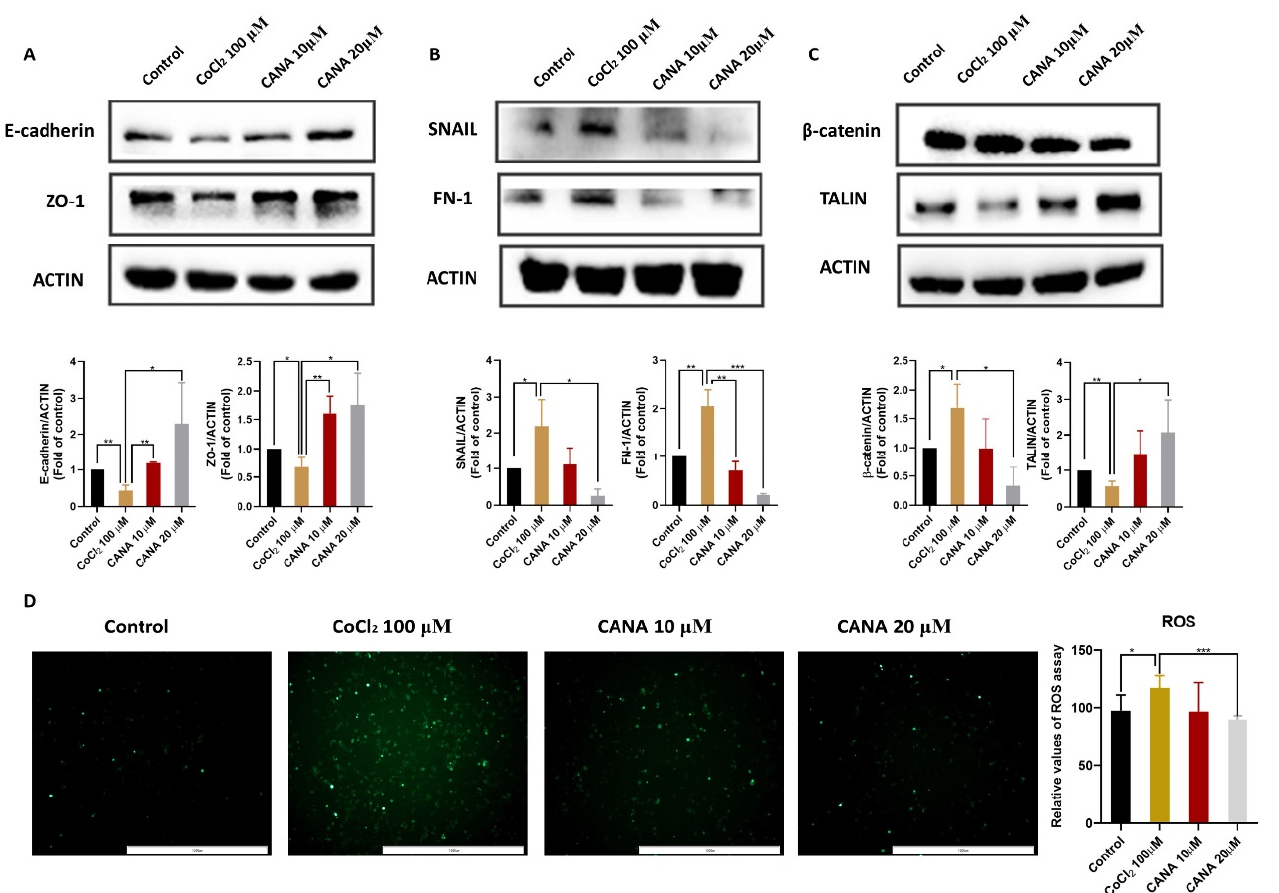
Figure 2. CANA inhibited hypoxia-induced epithelia-to-mesenchymal transition. ( A ) Effect of CANA on the protein expression of the epithelial marker in hypoxia-induced HepG2 cells after 24 h. ( B ) Effect of CANA on the protein expression of the mescenchymal marker in hypoxia-induced HepG2 cells after 24 h. ( C ) Effect of CANA on the protein expression of β -catenin and talin in hypoxia-induced HepG2 cells after 24 h. ( D ) Effects of CANA on reactive oxygen species (ROS) in hypoxia-induced HepG2 cells after 24 h (100 × ). Data were shown as means ± S.D. ( n = 3); * p < 0.05, ** p < 0.01, and *** p < 0.001. Control, normal untreated control; CANA, CANA-treated CoCl2 (100 µ M)-induced group.